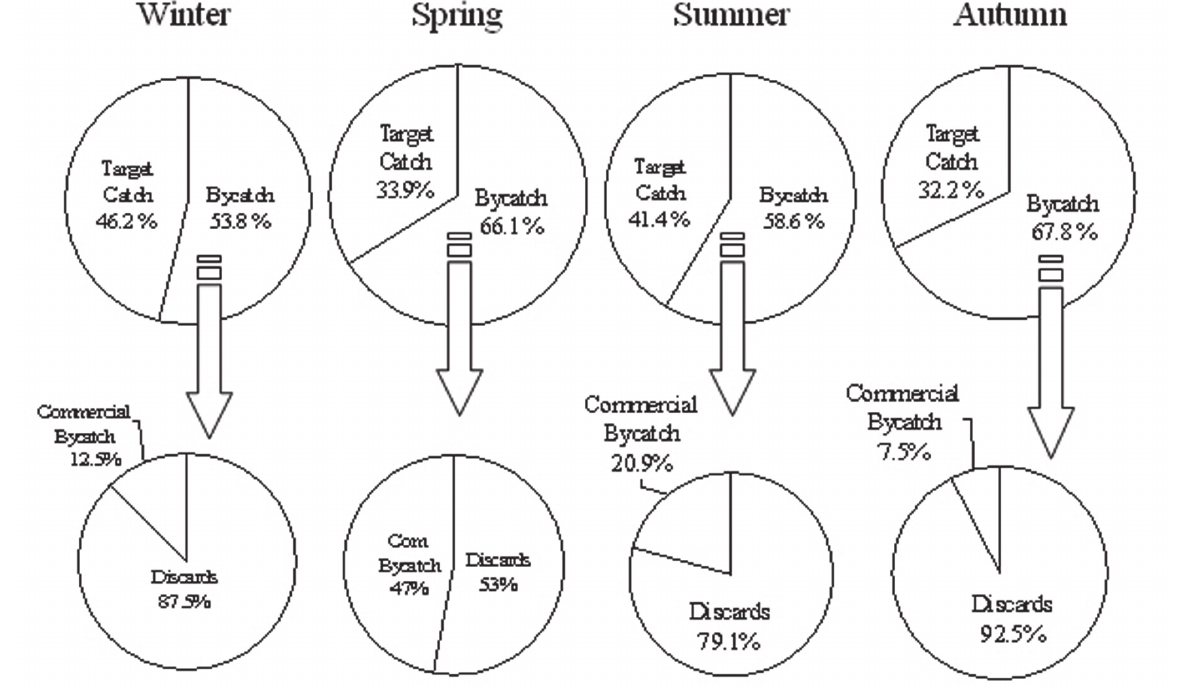
Fig . 3. – overall catch composition of the crustacean trawl according to season.